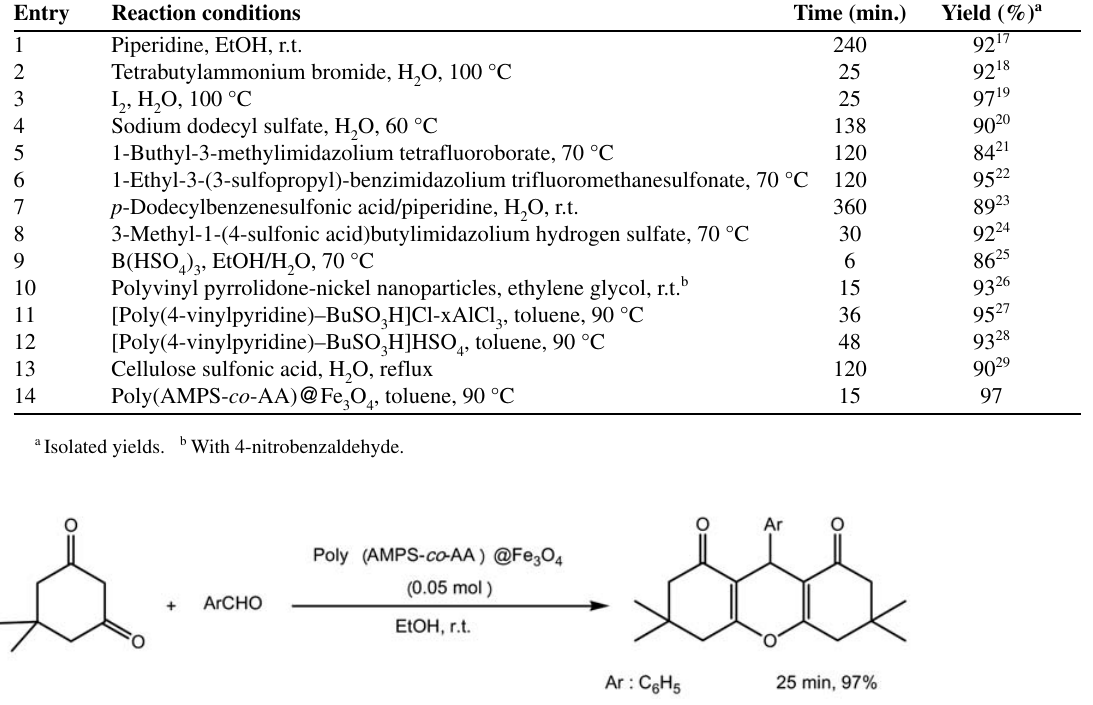
Figure 8. Recyclability of poly(AMPS- co -AA) @ Fe mmol) in the reaction of benzaldehyde (1 mmol) with 4-hydroxy- coumarin (2 mmol) in toluene at 90 °C after 15 min.